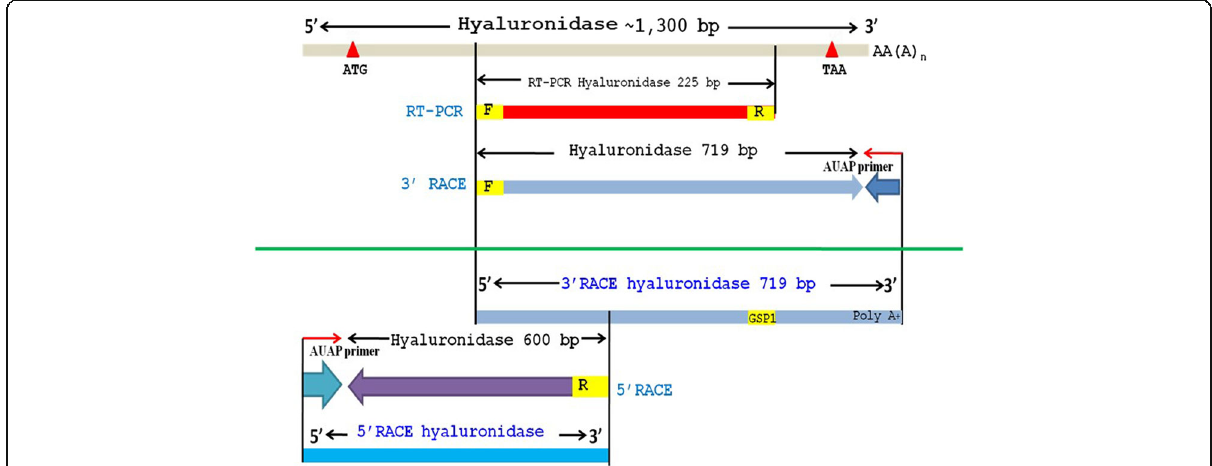
Fig. 1 The cloning strategies of Vespa tropica HAase (VesT2s). The 357 amino acid sequence of VesT2s was deduced by overlapping of the VesT2s HAase gene and determined by using RT-PCR and